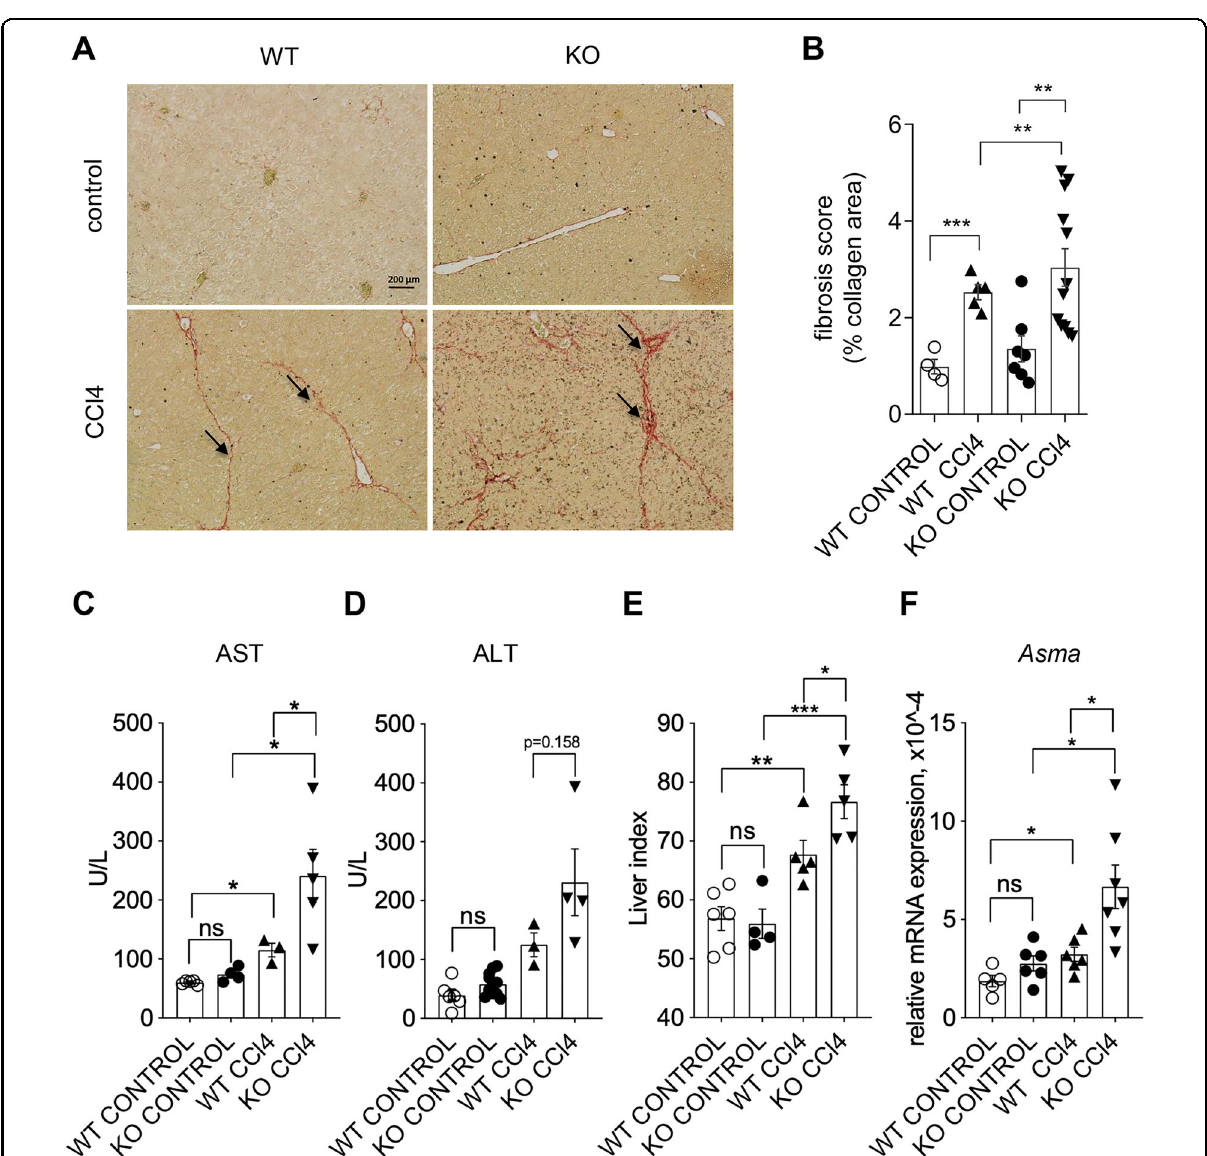
Fig. 1 Lack of GILZ results in increased CCl 4 -induced liver fi brosis development. A Sirius Red staining of liver sections from 4-month-old WT and GILZ KO mice that had been treated with oil (control; upper panels) or CCl 4 (lower panels) for 6 – 7 weeks. Arrows indicate the areas of collagen deposition. B Graph shows the quantitative measurement of collagen deposition in all experimental groups. C , D AST ( C ) and ALT ( D ) levels in blood from 4-month-old WT and GILZ KO mice that had been treated with CCl 4 for 6 – 7 weeks. E LI of 4-month-old WT and GILZ KO mice that had been treated with oil (control) or CCl4 for 6 – 7 weeks. F qPCR analysis of Asma mRNA expression in livers from 4-month-old WT and GILZ KO mice that had been treated for 6 – 7 weeks with oil (control) or CCl 4 . All data are presented relative to Actb mRNA expression. Each dot represents an individual mouse; bars indicate the mean. Results are presented as the means ± SEM of three ( A , B , F ) or two ( C – E ) independent experiments (* p < 0.05, *** p < 0.001, ns not signi fi